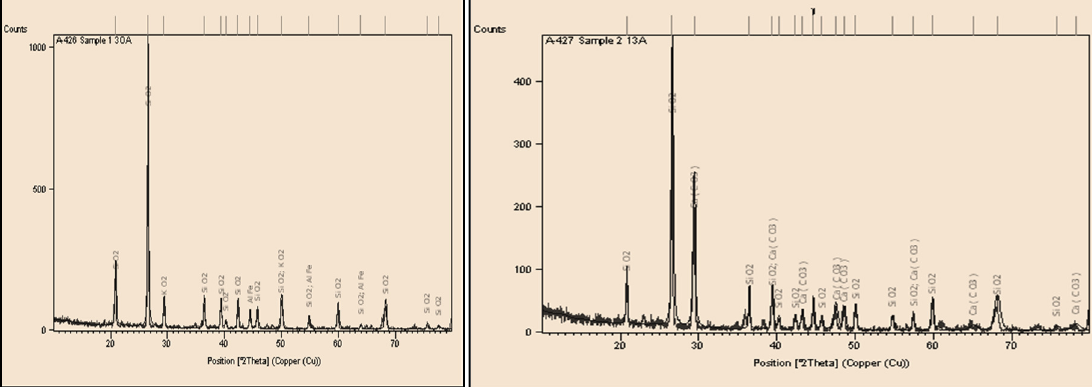
Fig. 4: Bulk Powdered XRD Profile Data of the two samples from Nari Formation